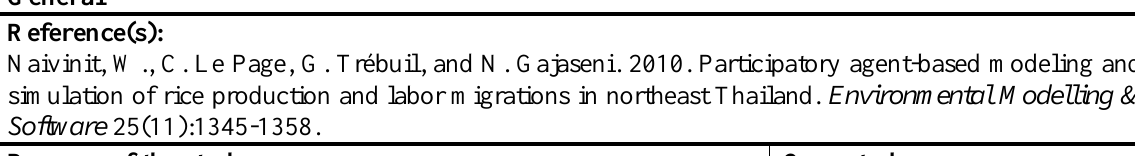
Table A1.8 Standardized protocol for the ABM described by Naivinit et al.